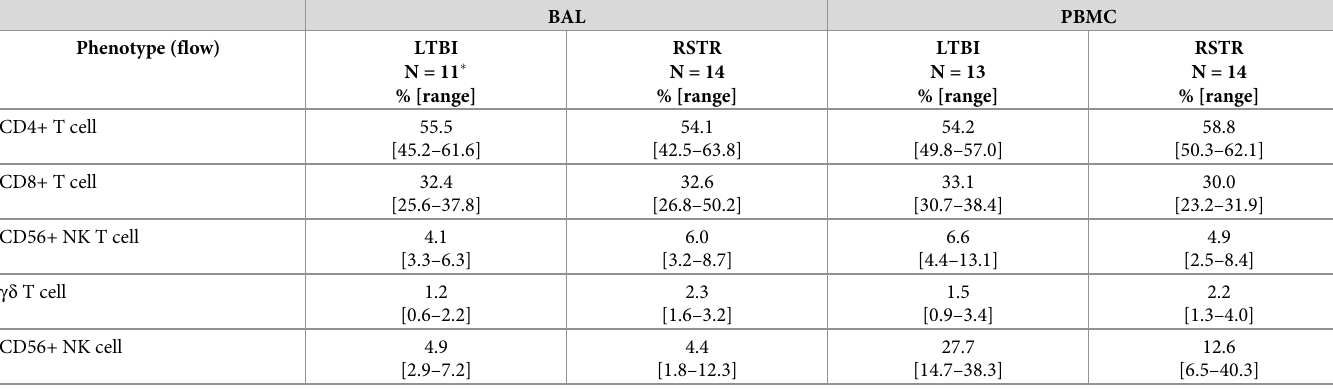
Table 3. CD3+ T cell subset and CD3- NK cell percentages in BAL and PBMC lymphocytes from LTBI and RSTR participants.